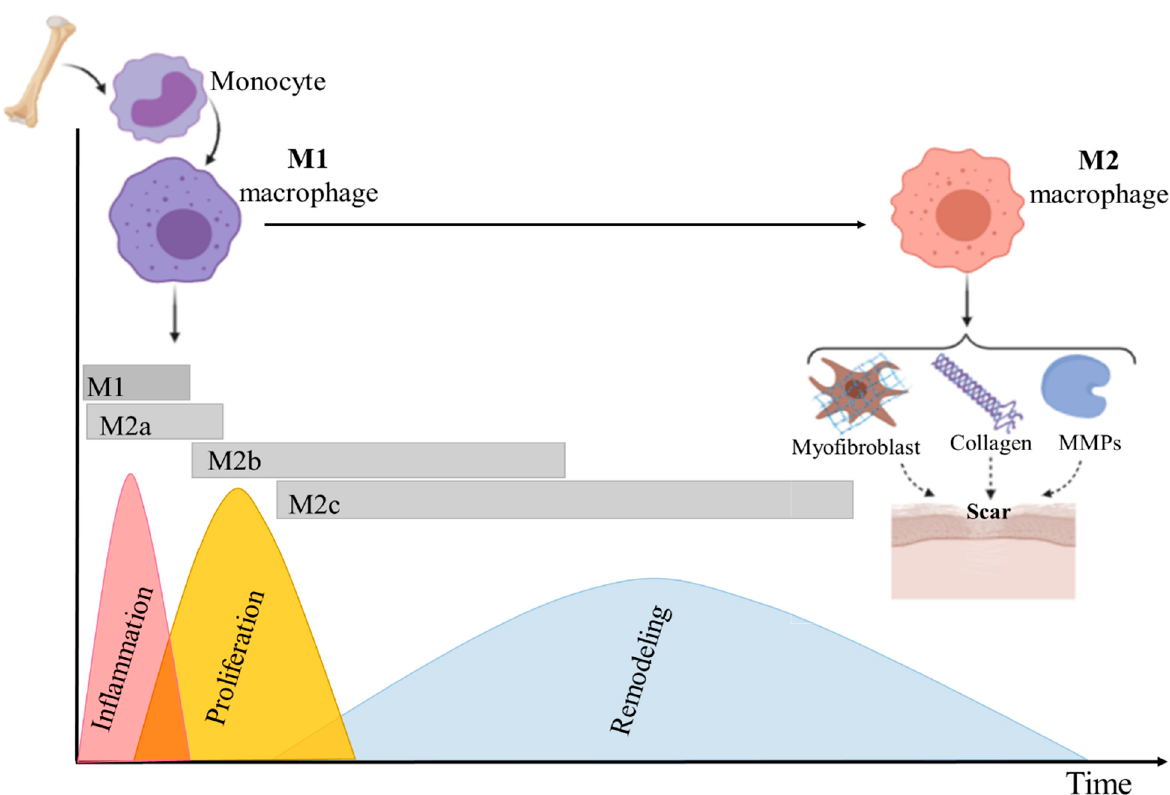
Figure 2. Schematic representing macrophage plasticity in wound healing. As the wound healing stages progress and the wound microenvironment changes, M1 pro-inflammatory macrophages undergo a phenotypic switch to an M2 anti-inflammatory and proregenerative state, which stimulates tissue regeneration. Thus, macrophages regulate the transition from the inflammatory to the prolif- erative phase of healing. Furthermore, macrophage phenotypic switch from M1 to M2 effects scar formation by inducing fibroblast proliferation, myofibroblast differentiation, synthesis of different MMPs, and various types of